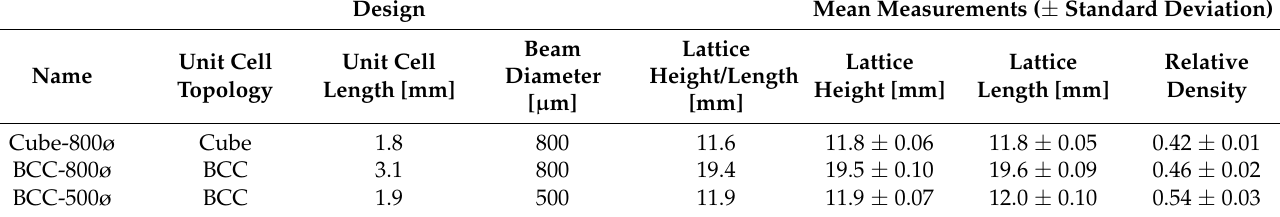
Table 1. Design and mean measured dimensional characteristics of lattices. All lattices were designed with 40% relative density.